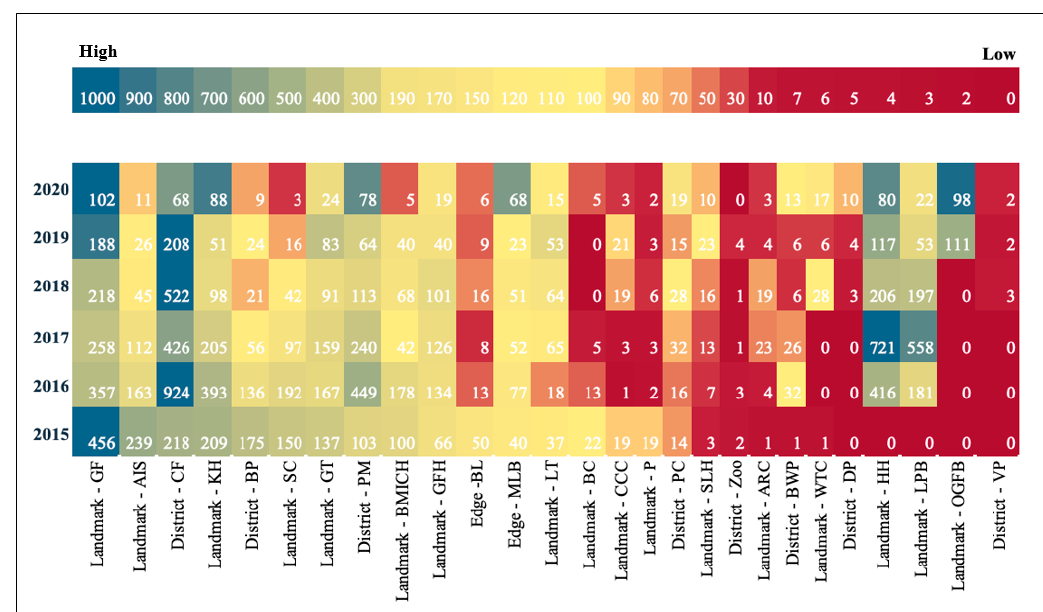
Figure 7. Color density matrix: Twitter popularity analysis. The frequency of the posts shared on Twitter and Instagram shows the community perceptions toward making memories with the places. According to Figure 7, GF, AIS, CF, KH, HH, LPB, PM, and BMICH can be considered the places which have received high attention on Twitter and Instagram. Table 3 shows the exemplary positively and nega- tively classified tweets, where Table 4 lists the frequently used word in the Twitter and Instagram posts shared per selected locations with increasing popularity. Table 3. Exemplary positively and negatively classified tweets. Place Code